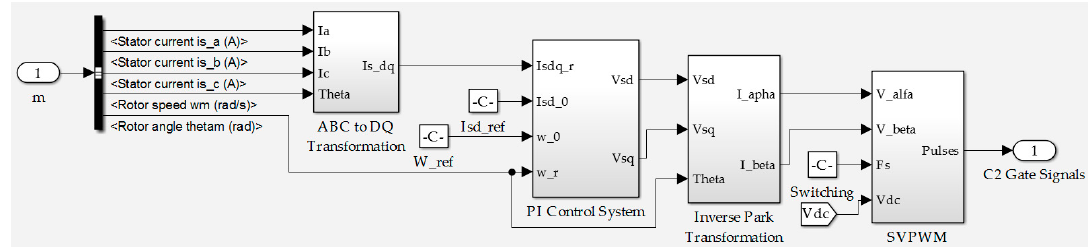
Figure 7. SVPWM subsystem.